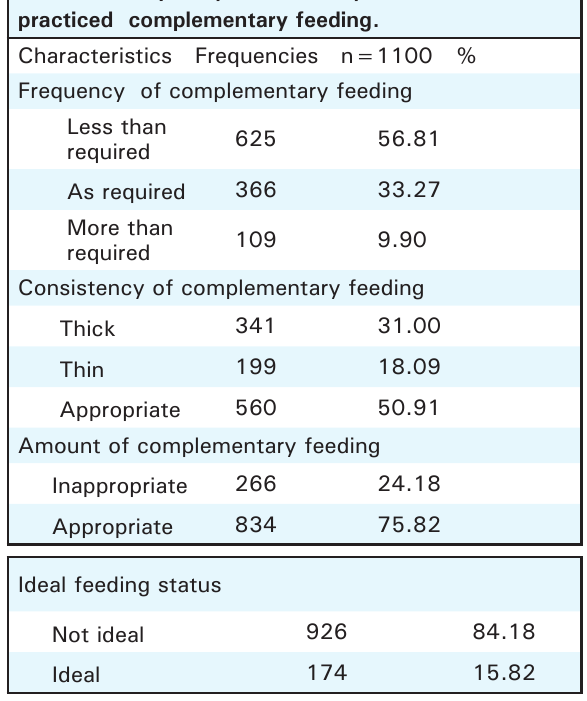
Table 4. Frequency, consistency and amount of practiced complementary